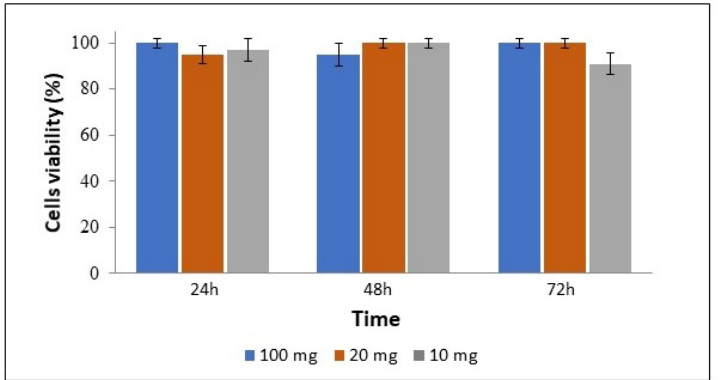
Figure 7. Cell viability of C8166 cells after treatment with CS/hsDNA complexes at concentrations of 100, 20 ×10 10 µg/mL for 24, 48 and 72 h.